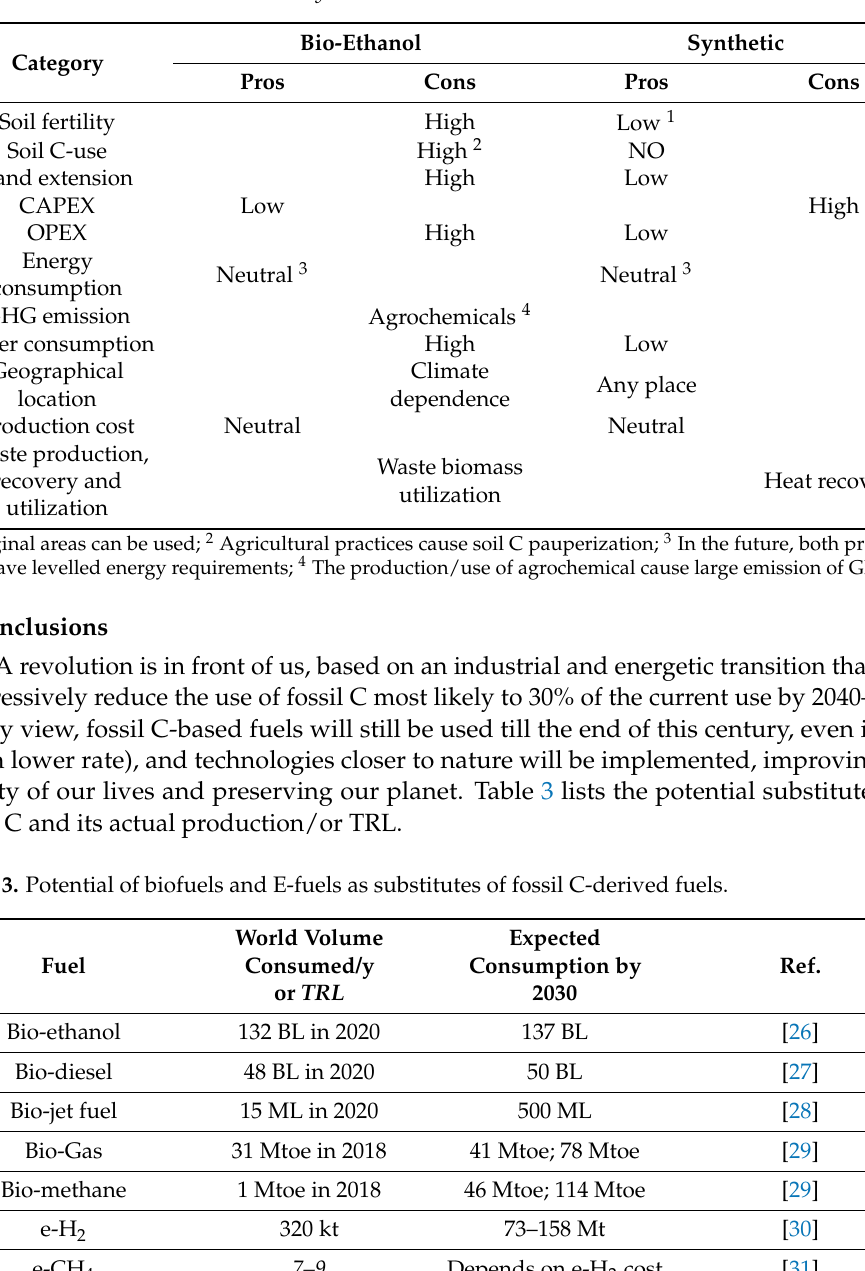
Table 2. Pros and cons of the bio and synthetic route to ethanol.